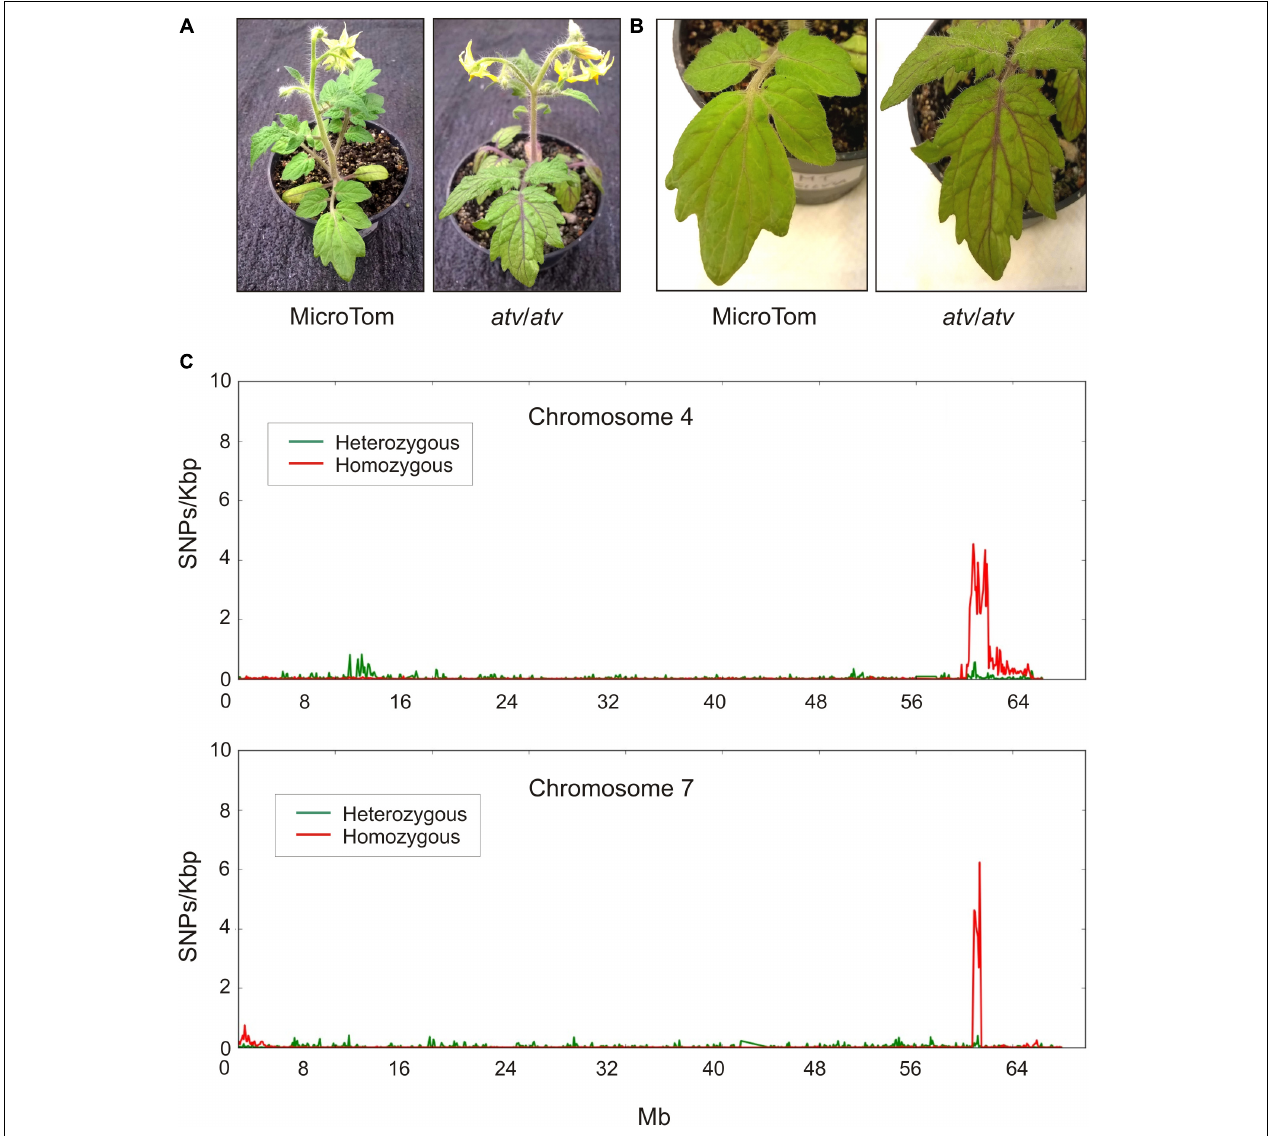
FIGURE 1 | Tomato atv mutants show increased anthocyanins levels and contain extensive introgression regions in their genome. Phenotype of MicroTom (MT) and atv / atv plants (in MT background): (A) whole plants; (B) detail of leaves. (C) Distribution of the density of homozygous and heterozygous single nucleotide polymorphisms (SNPs) along chromosomes 4 and 7 of atv / atv